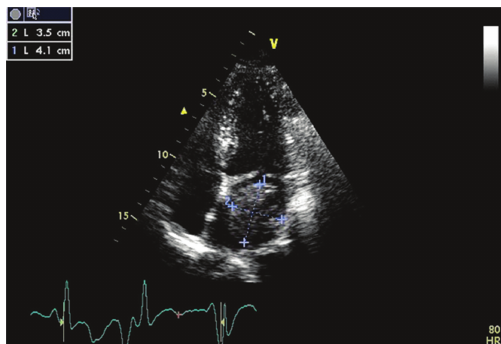
Figure 3: Transthoracic echocardiogram showing left atrial mass obstructing left ventricular outlet tract and originating from left superior pulmonary vein.